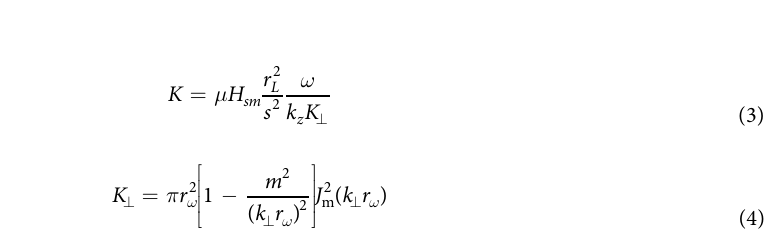
where H sm is the coupling coefficient, k ⊥ and k z are the transverse and longitudinal wave numbers, J m is the Bessel function of order m . Substituting the beam-wave equations in ref. 1 into these two expressions, the relationship between the magnetic field strength and the coupling impedance is obtained as shown in Fig. 4a. Each peak cor- responds to the singular cutoff point of a mode, where it assumes k z = 0. Comparing the absolute values of K for different modes, we can demonstrate the quantitative coupling strengths under different magnetic field strengths and operating frequencies. Anomalous intersections in impedance curves show that competing modes in the near-cutoff region are very dangerous for whispering-gallery modes.